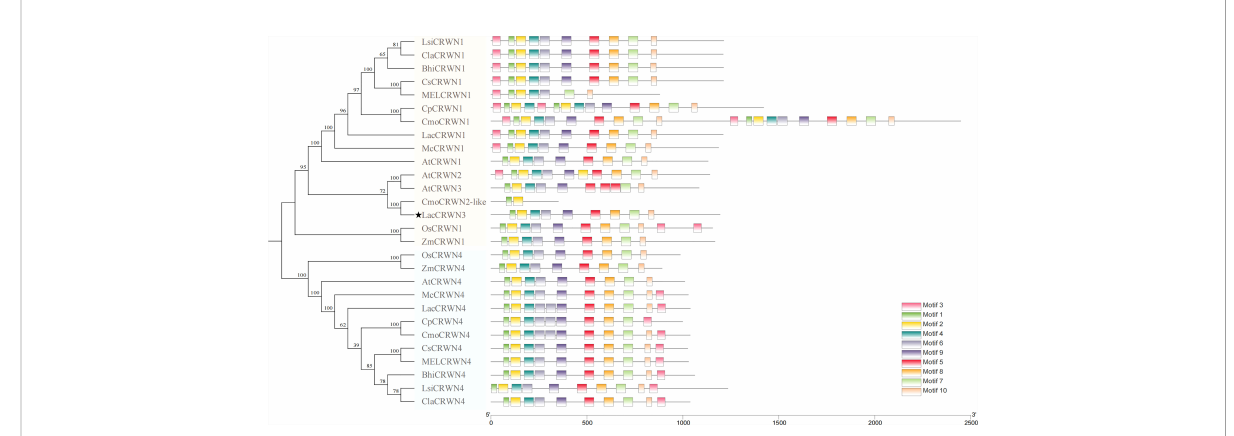
FIGURE 5 Phylogenetic and conserved motif analysis of LacCRWN3 . The protein sequences of the LacCRWN3 family were from Luffa , the other eight Cucurbitaceae species, Arabidopsis , rice and